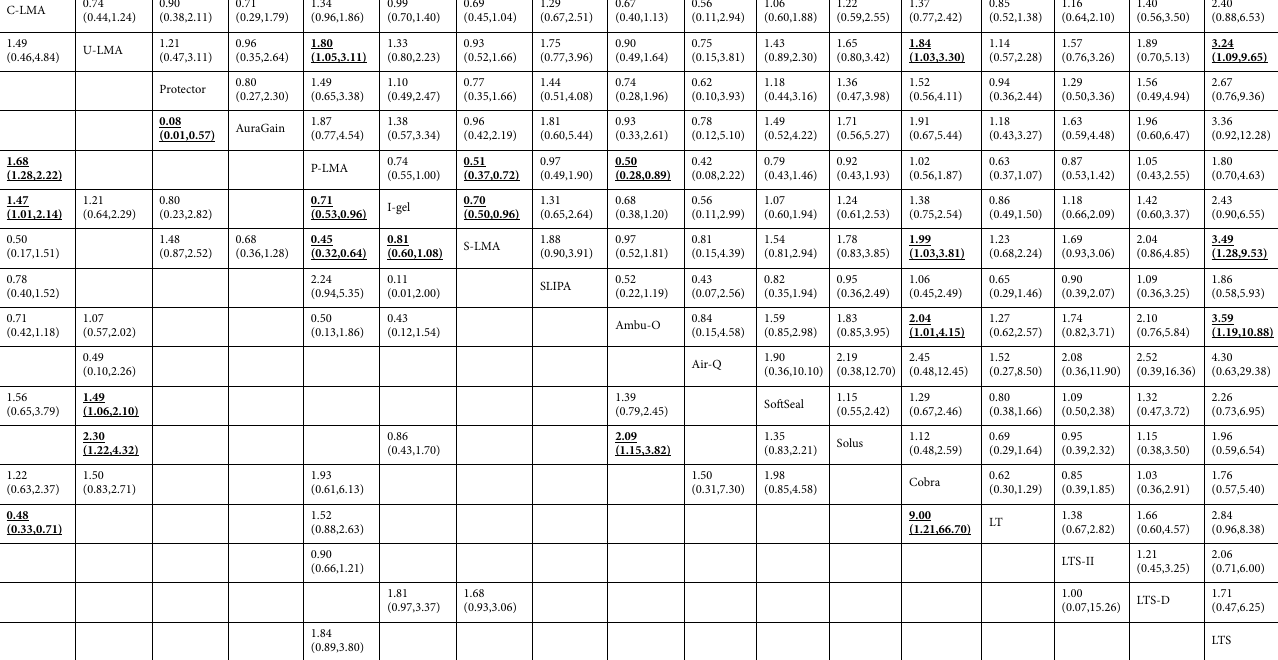
Table 3. Results for the risk of first-attempt insertion failure from network meta-analysis and pairwise meta-analysis. The device in column one is the index device and that in row one is the comparator. The upper triangle is the results of the network meta-analysis, and the lower triangle is the results of the traditional pairwise meta-analysis. The device in column one is divided by the device in the row one equals the risk ratio, which did not have unit. Bold and underscored means significance. The significance means the confidence interval not containing the “1”. C-LMA, LMA Classic; U-LMA, Unique LMA; Protector, LMA Protector Airway; AuraGain, Ambu AuraGain Disposable Laryngeal Mask; P-LMA, Proseal LMA; I-gel, I-gel supraglottic airway; S-LMA, Supreme LMA; SLIPA, Streamlined Liner of the Pharynx Airway; Ambu-O, Ambu AuraOnce; Air-Q, Air-Q Masked Laryngeal Airway.; SoftSeal, The Portex Soft Seal Laryngeal Mask; Solus, Solus Standard laryngeal mask airway; Cobra, Cobra Perilaryngeal airway; LT. Laryngeal Tube; LTSII, Laryngeal Tube Suction II; LTS-D, Laryngeal Tube Disposable; LTS, Laryngeal Tube